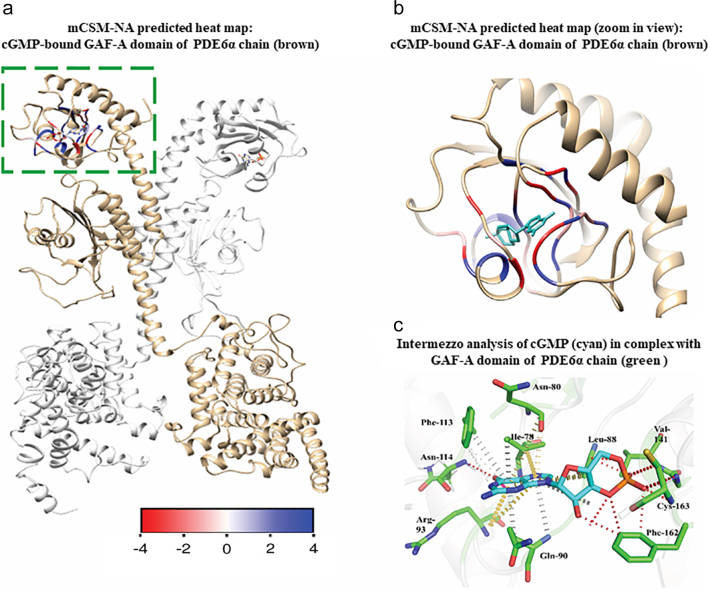
a) Heat map showing the average predicted changes upon mutation in cGMP-binding residues of PDE6α Gaf-A domain using mCSM-NA (b). zoom in view of cGMP bound Gaf-A domain and predicted effect of mutations in cGMP interacting residues of Gaf-A domain is shown through a colored gradient scale that starts from blue indicating the average stabilizing effect (>0 kcal/mol), slightly destabilizing (≥−2.00 kcal/mol) (white) and highly destabilizing (<−2.00 kcal/mol) (highlighted in red). c) depicts Intermezzo analysis of cGMP binding with the wild type residues of Gaf-A domain of PDE6 through non-covalent interactions. Red dotted lines indicate hydrogen bonds as well as van der wal interactions of the cGMP molecule with Leu-88, Asn-114, Val-141, Phe-162 and Cys-163. Hydrophobic interactions involving ring-ring and ring-atom interactions between cGMP molecule and Phe-162, Ile-78, Gln-90 are shown in grey color while inter-residue interactions of Ile-78, Asn-87 and Arg-93 with the ring atoms of the cGMP molecule are shown in light yellow color.